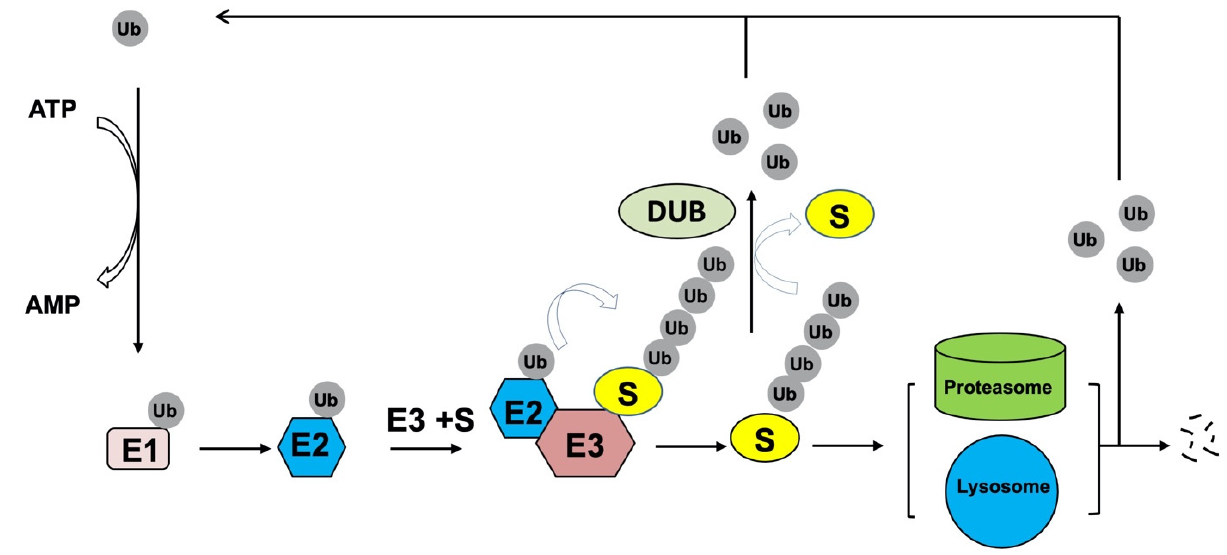
Figure 2. Ubiquitin pathway. During the catalytic reactions of ubiquitination, the small ubiquitin (Ub) protein is initially activated by a ubiquitin activating enzyme (E1) in an ATP-dependent manner, then transferred to the active cysteine residue of a ubiquitin conjugating enzyme (E2), and finally attached to a specific substrate through an isopeptide bond. Substrate specificity is determined by a cognate ubiquitin ligase (E3) that binds the substrate and E2. Typically, polyubiquitylation controls protein homeostasis by targeting substrates for degradation by the 26S proteasome and/or lysosome. Deubiquitinating enzymes (DUBs), which hydrolyze isopeptide or peptide bond, can remove Ub conjugates from substrates and disassembling anchored Ub chains to reverse ubiquitination process. The released ubiquitin molecules can be recycled.